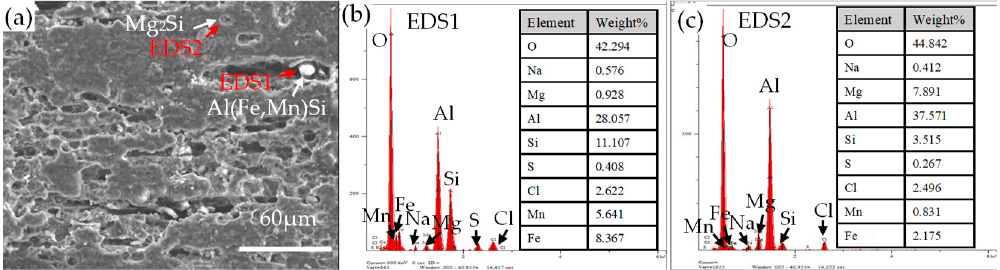
Figure 4. ( a ) SEM of a 5083/6005A welded joint corroded for 30 days; ( b ) EDS1 results; ( c ) EDS2 results.